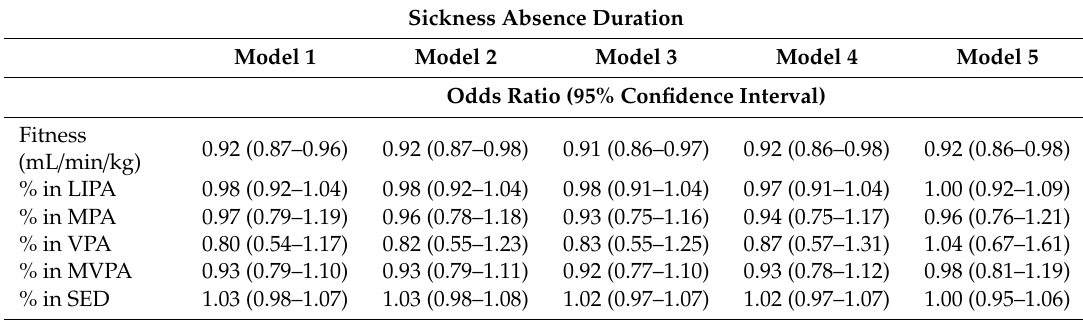
Table 2. Odds of sickness absence ≥ 8 days per year according to baseline fitness, and percentage in LIPA, MPA, VPA, MVPA, and SED ( n = 159).